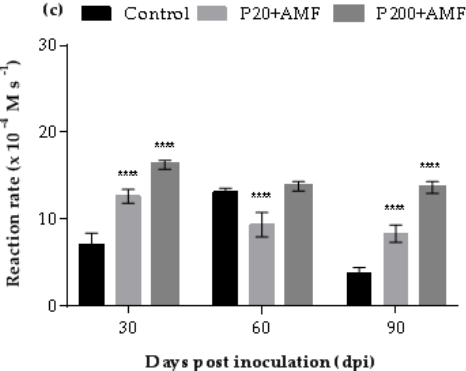
Figure 4. Variation in lipoxygenase activity in P. divaricatum : ( a ) plants treated with 20 and 200 mg of P · dm − 3 of soil (P20 and P200); ( b ) plants inoculated with AMFs (AMF); ( c ) plants inoculated with AMFs and treated with 20 and 200 mg of P · dm − 3 of soil (P20 + AMF and P200 + AMF). Statistical difference according to Bonferroni test ( p < 0.05). Significance level: **** extremely significant ( p < 0.0001), *** very significant ( p < 0.001), ** low significant ( p < 0.01).